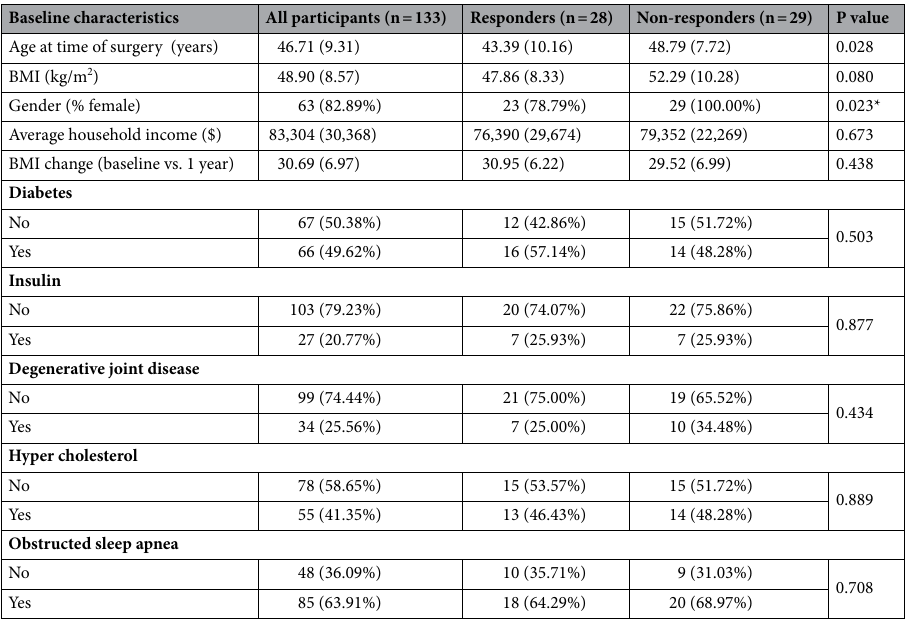
Baseline characteristics